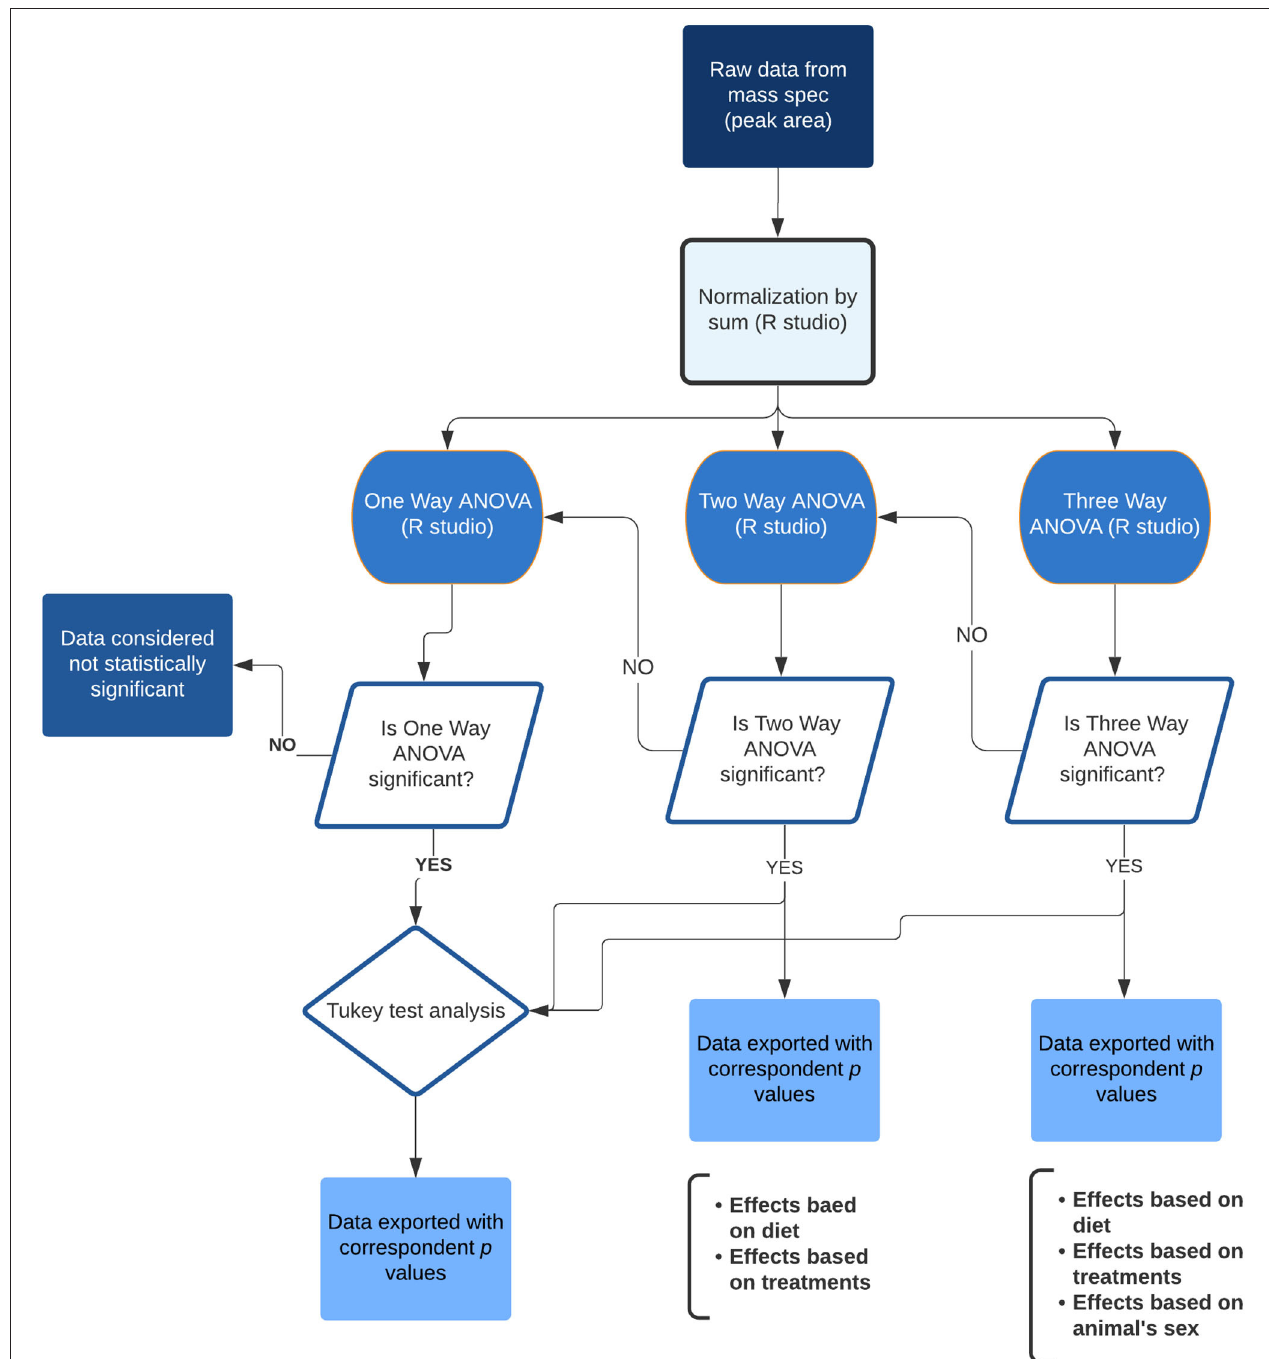
FIGURE 2 | Flowchart showing the statistical analysis steps of the lipidomic data. Final data was exported to spreadsheets containing the p- values related to the ANOVA and effects from the diet, treatments and animal’s sex, as well as the individual comparison between groups.